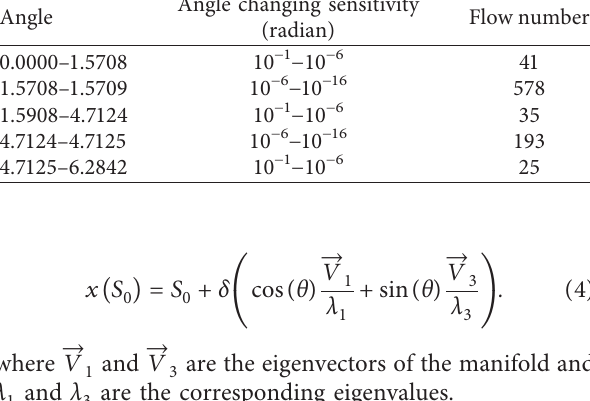
Table 1: The flows with the changing angle. Angle changing Angle